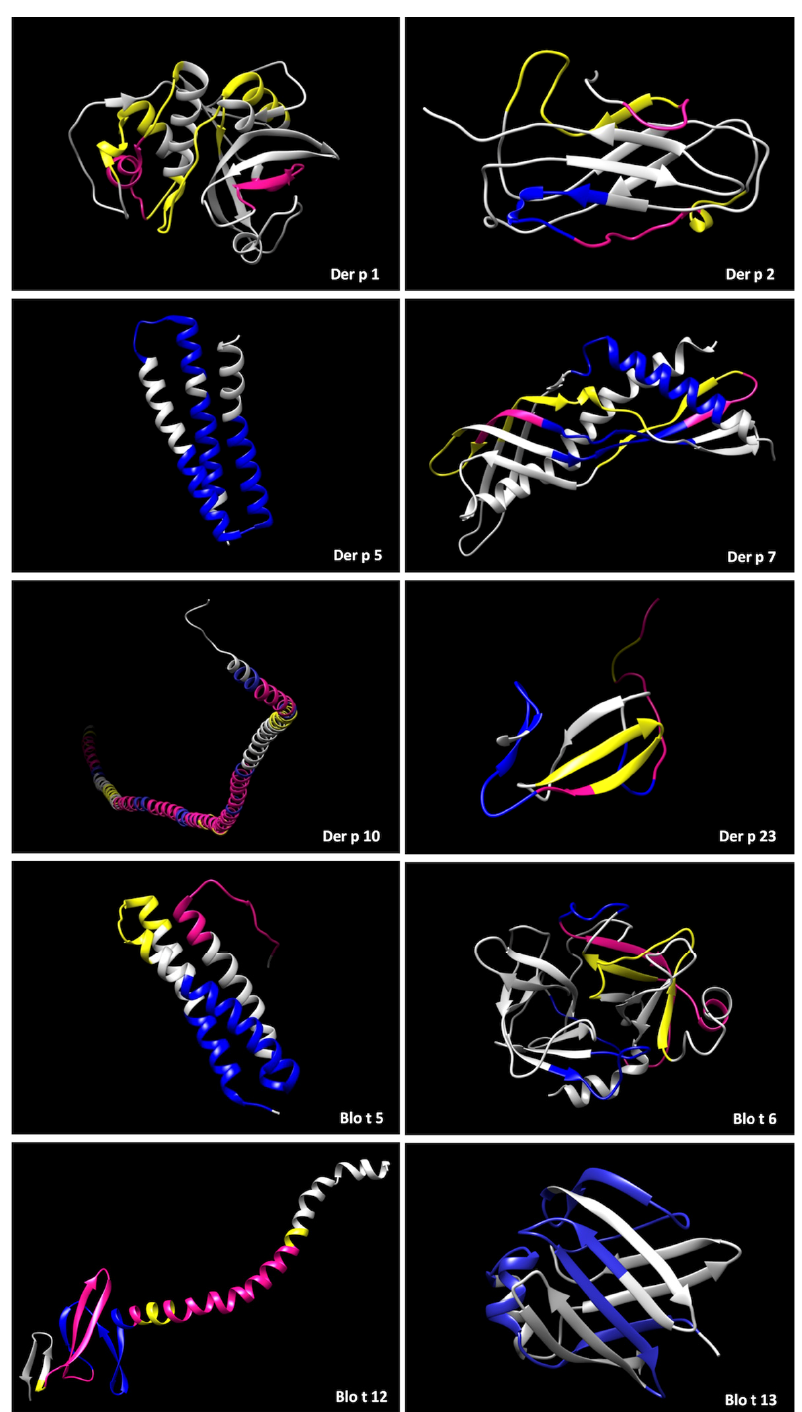
Figure 4. Protein modeling of tertiary structure of allergens highlighting peptides/epitopes detected in the microarray. In yellow, IgE pre-SLIT binding epitopes, in blue, IgG4 post-1-year binding epitopes, and in pink, regions where both antibodies have affinity.